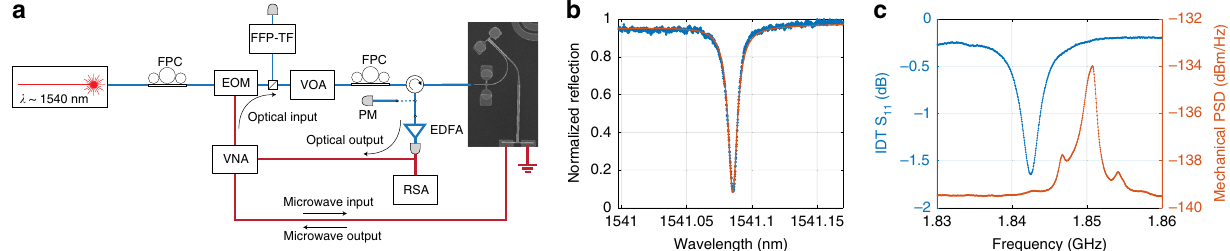
Fig. 2 Measurement setup and separate characterizations of the IDT and the OMC. a Schematic drawing of the measurement setup. The optical sideband input is generated by a microwave tone from the vector network analyzer (VNA) to the electro-optic modulator (EOM). Optical readout of the sideband is generated by a high-speed photodetector, and is sent back to the VNA. Microwave input and output of the device is directly actuated by and measured from the IDT. b Optical resonance of the optomechanical crystal. c IDT response (blue) and OMC mechanical mode thermal spectroscopy (red). VOA variable optical attenuator, FPC fi ber polarization controller, EDFA erbium-doped fi ber ampli fi er, RSA real-time spectrum analyzer, PM power meter, FFP-TF fi ber Fabry – Pérot tunable fi